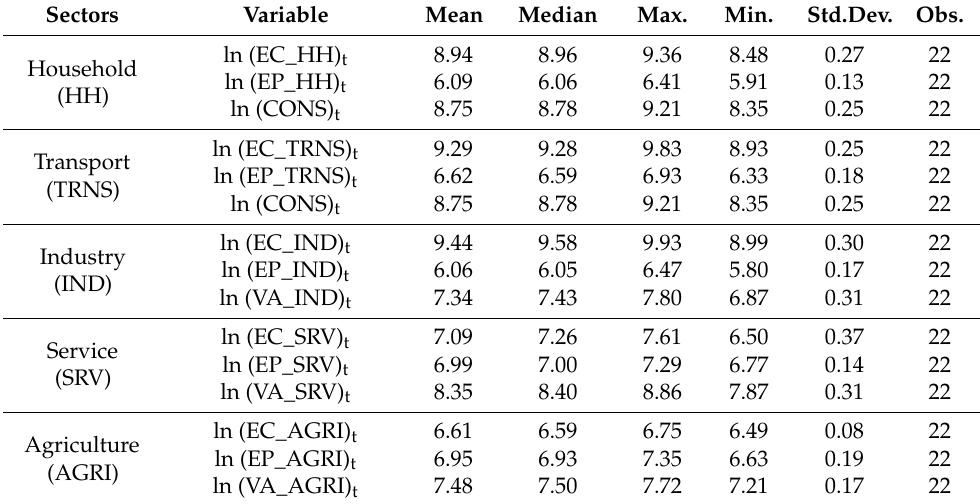
Table 5. Descriptive analysis of variables (in log form) for econometric analysis.